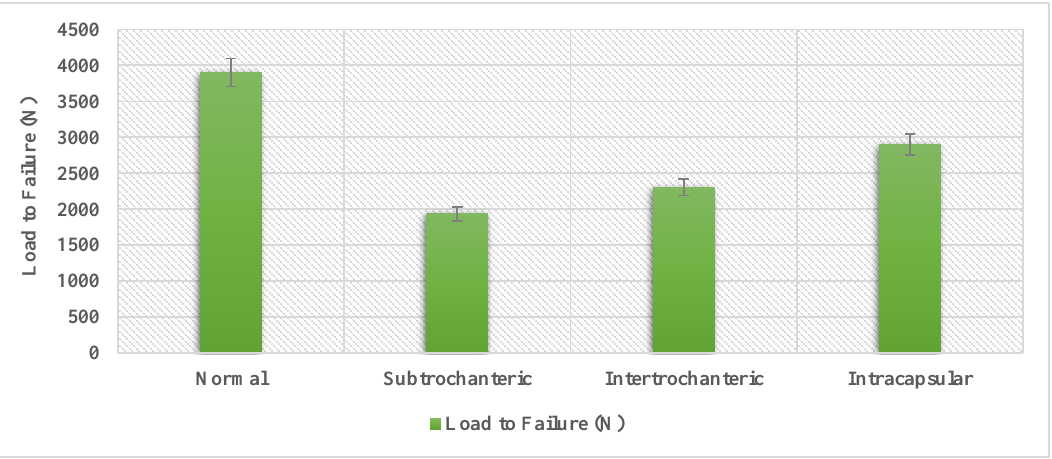
Figure 13. Load to failure in axial compression scenario . Table 10. Max stress from the loading simulations, where BW is the body weight.